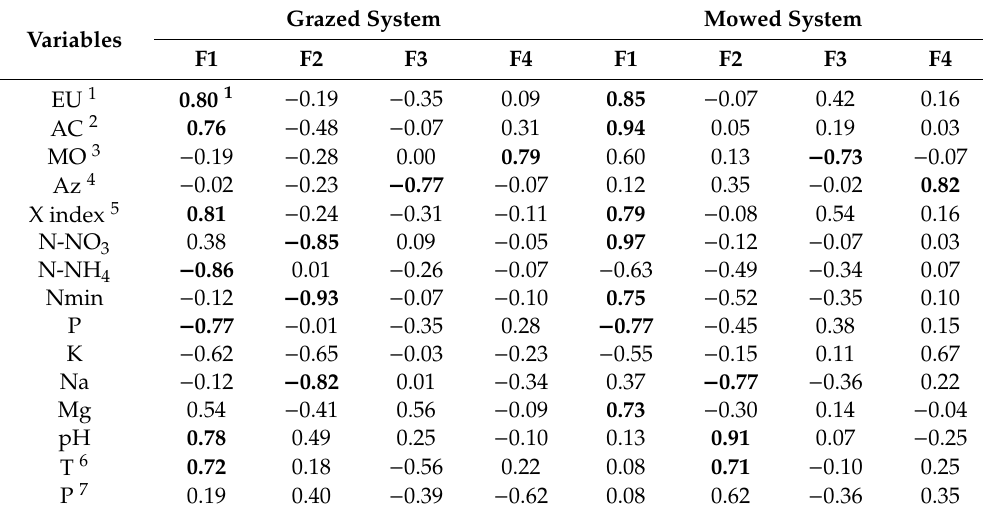
Table 4. Pearson correlation matrix between soil microbial and chemical characteristics and PCA factors. Grazed System Mowed System Variables F1